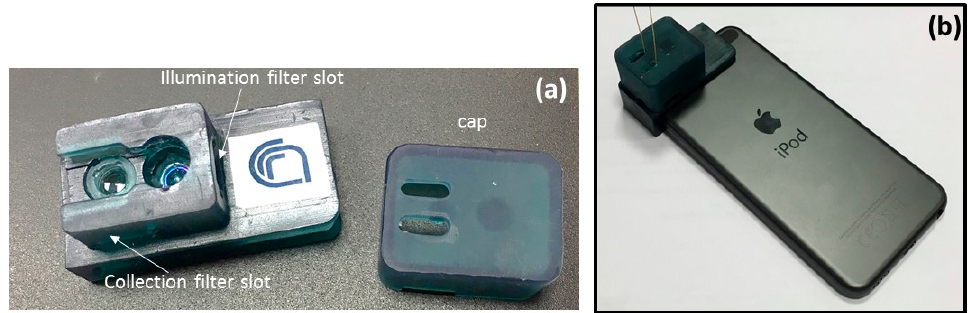
Figure 6. ( a ) Picture of the plastic 3D-printed holder and ( b ) view of the whole system coupled to the iPod.